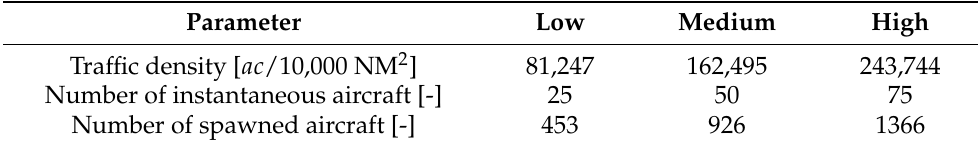
Table 2. Traffic volume used in the experimental